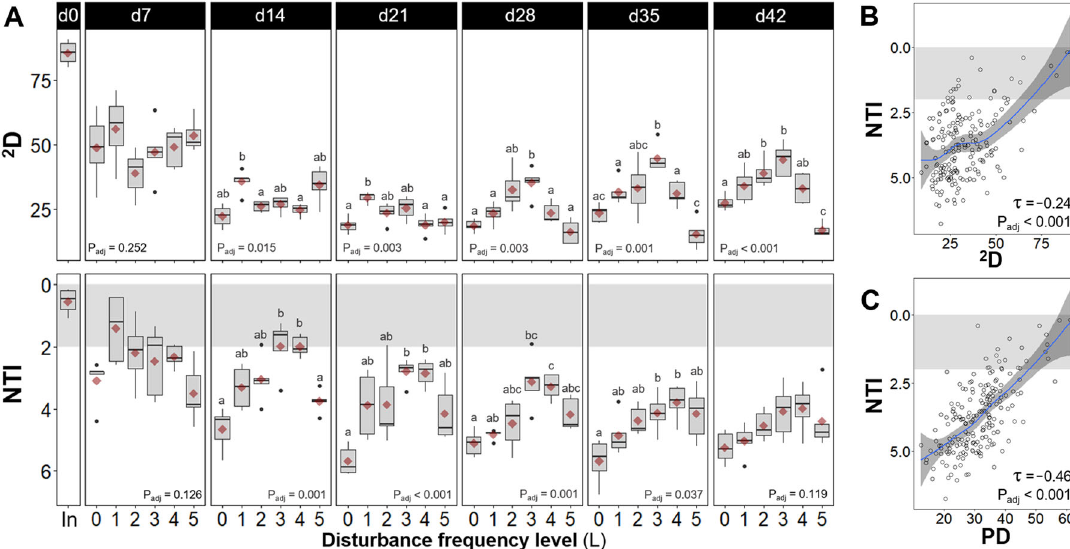
Fig. 1 Community dynamics in α -diversity. A Community structure assessed via 2nd order Hill α -diversity ( 2 D, upper panels) and community assembly evaluated via the nearest taxon index (NTI, lower panels), from bacterial ASV data for different frequencies of organic loading disturbance ( n = 5). Disturbance frequency levels (L): 0 (undisturbed), 1 – 4 (intermediately disturbed), 5 (press disturbed). In: sludge inoculum (day 0, n = 4). Each panel represents a sampling day, red diamonds display mean values. The box bounds the interquartile range (IQR) divided by the median, and Tukey-style whiskers extend to a maximum of 1.5 times the IQR beyond the box. Characters above boxes display Games- Howell post hoc grouping ( P adj < 0.05). Welch ’ s ANOVA P -values adjusted at 5% FDR shown within panels. Correlations of B 2 D and C phylogenetic diversity (PD) vs. NTI from bacterial ASV data across all frequency levels and time points evaluated in this study ( m = 184). Kendall correlation τ - and adjusted P -values are indicated within the panel. Blue line represents locally estimated scatterplot smoothing regression (loess) with con fi dence interval in dark-gray shading. Note the inverted y -axis for NTI, as values closer to zero indicate a higher relative contribution of stochastic assembly. Shaded in gray is the zone of signi fi cant stochastic phylogenetic dispersion, |NTI | <